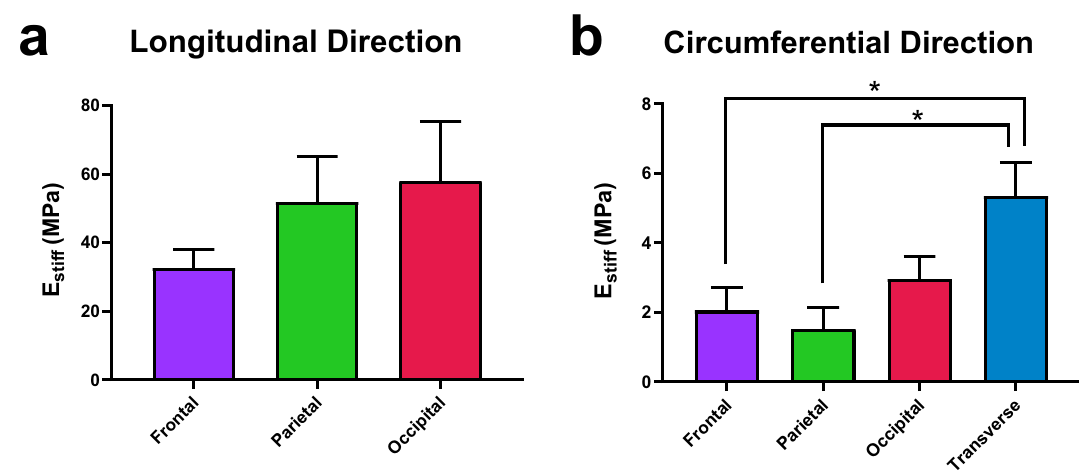
Figure 2. ( a ) Mean E stiff results for the samples tested in the longitudinal test direction utilising uniaxial tensile testing. ( b ) Mean E stiff results for the samples tested in the circumferential test direction utilising ring testing. *Statistical significance ( p < 0.05 ), error bars represent standard error about the mean. Note that the y-axis scale differs between ( a ) and ( b